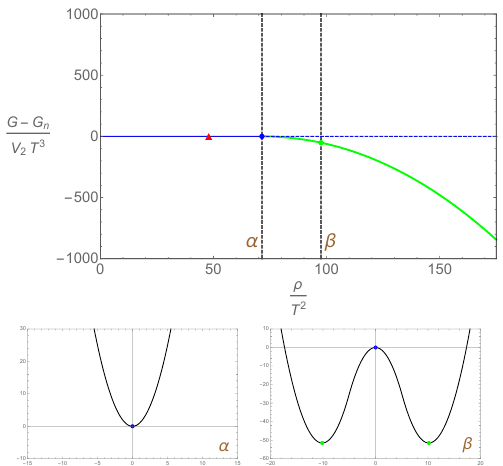
Figure 6 . The landscape viewpoint for 2nd order phase transition with the typical Mexican hat potential. The two bottom panels show the potential at the critical point and in the broken